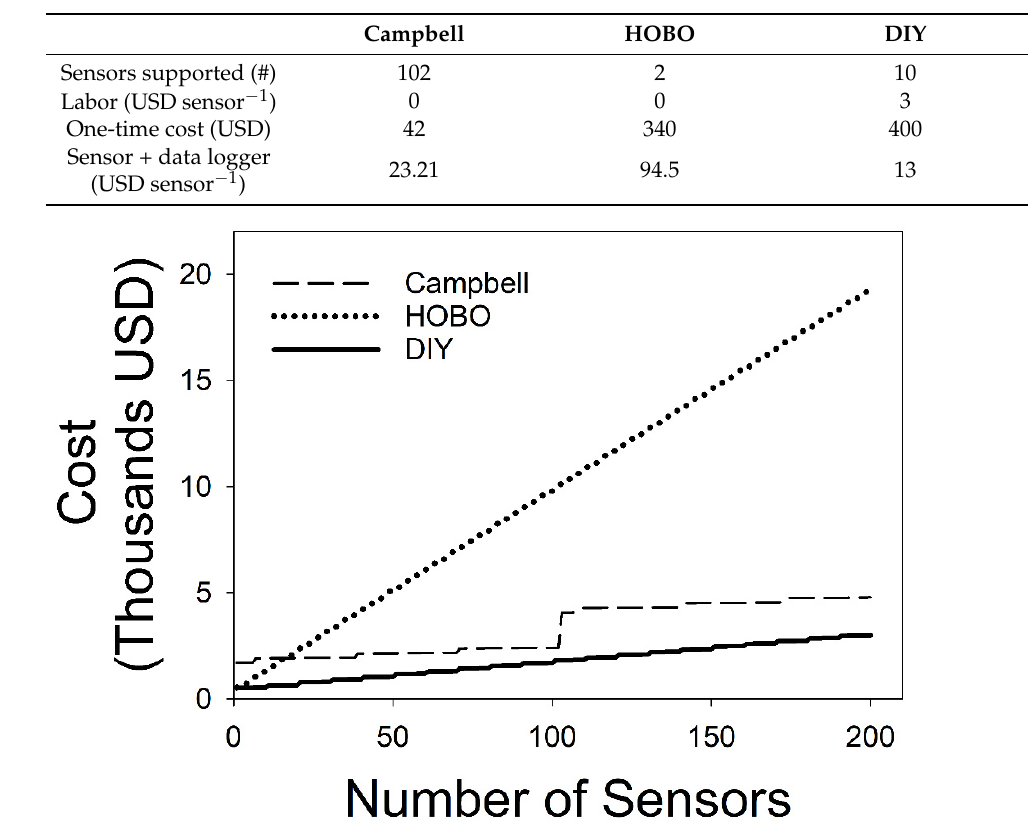
Table 2. Cost of three soil temperature data logger systems including our DIY soil temperature data logger setup in their most efficient configurations. One-time costs refer to reusable manufacturing tools, data transfer cables, and proprietary software.